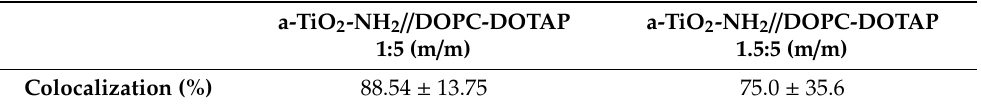
Table 1. Conjugation yield in percentage obtained for both mass ratio tested of Nanoparticles (NPs):Phospholipids (1:5 and